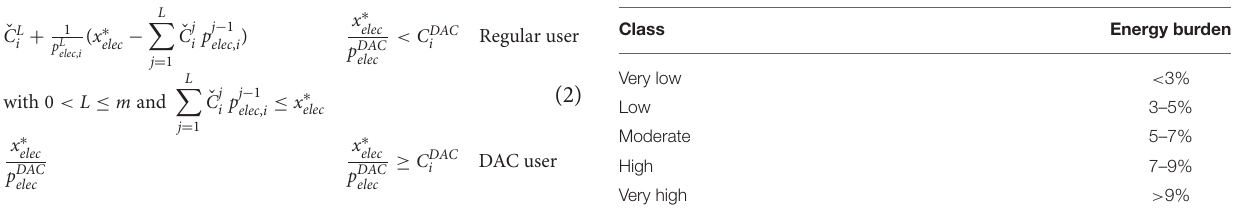
TABLE 2 | Classification of levels of energy